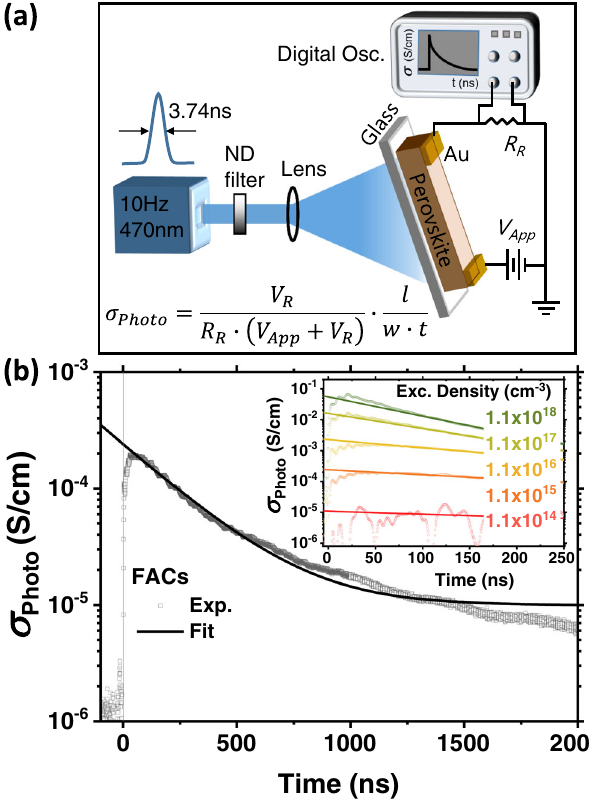
Fig. 1 Measurement and calculation of transient photo-conductivity (TPC). a Schematic illustration of the experimental setup and sample structure with in-plane electrodes used in this study. b Photo-induced transient change of conductivity and exponential decay fi tting for FACs polycrystalline perovskite thin- fi lms. Photo-conductivity ( σ Photo ) at t = 0 is extrapolated from the fi tted plot to calculate mobility. Inset shows σ Photo decays from the experiment and fi tting with various excitation densities (cm − 3